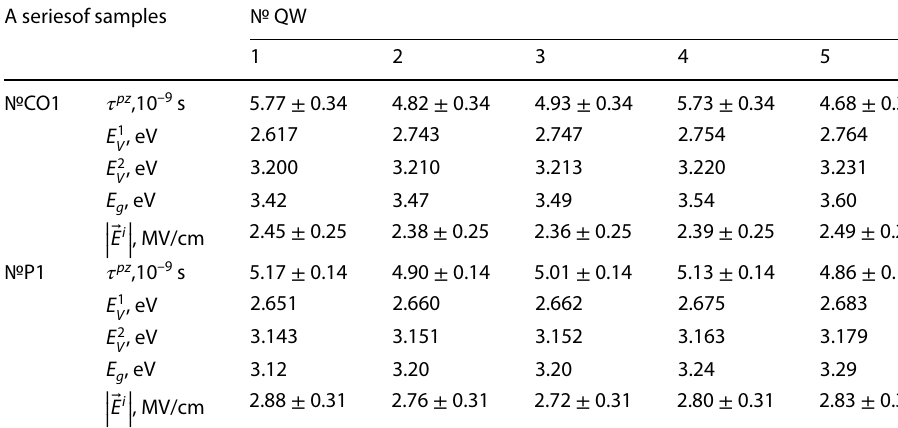
A seriesof samples